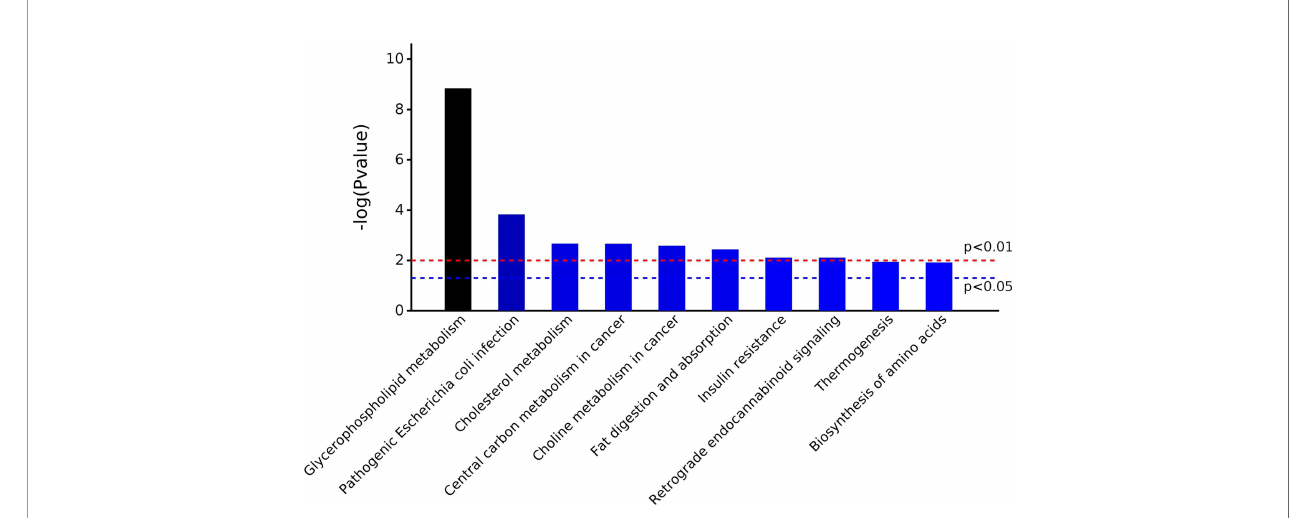
FIGURE 4 | The top 10 signi fi cantly enriched pathways in metabolomic analysis.